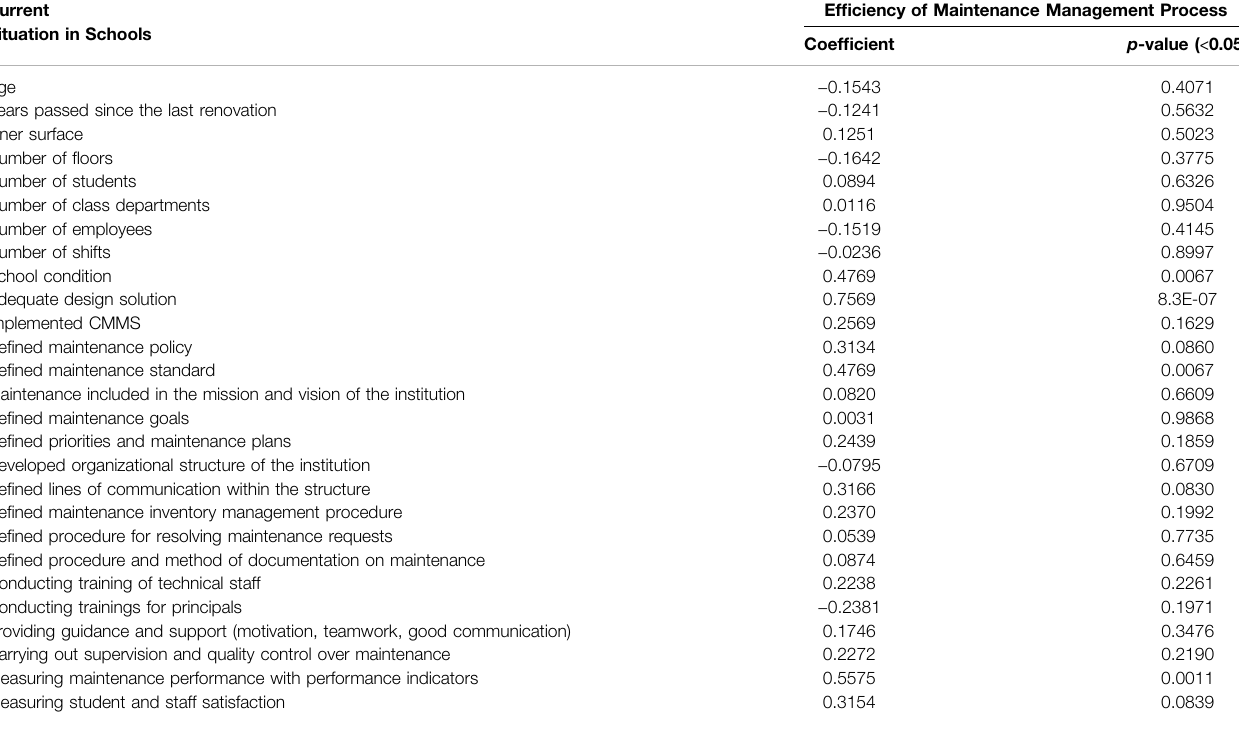
TABLE 5 | Correlation coef fi cients and p -values between the observed maintenance management factors. Current Situation in